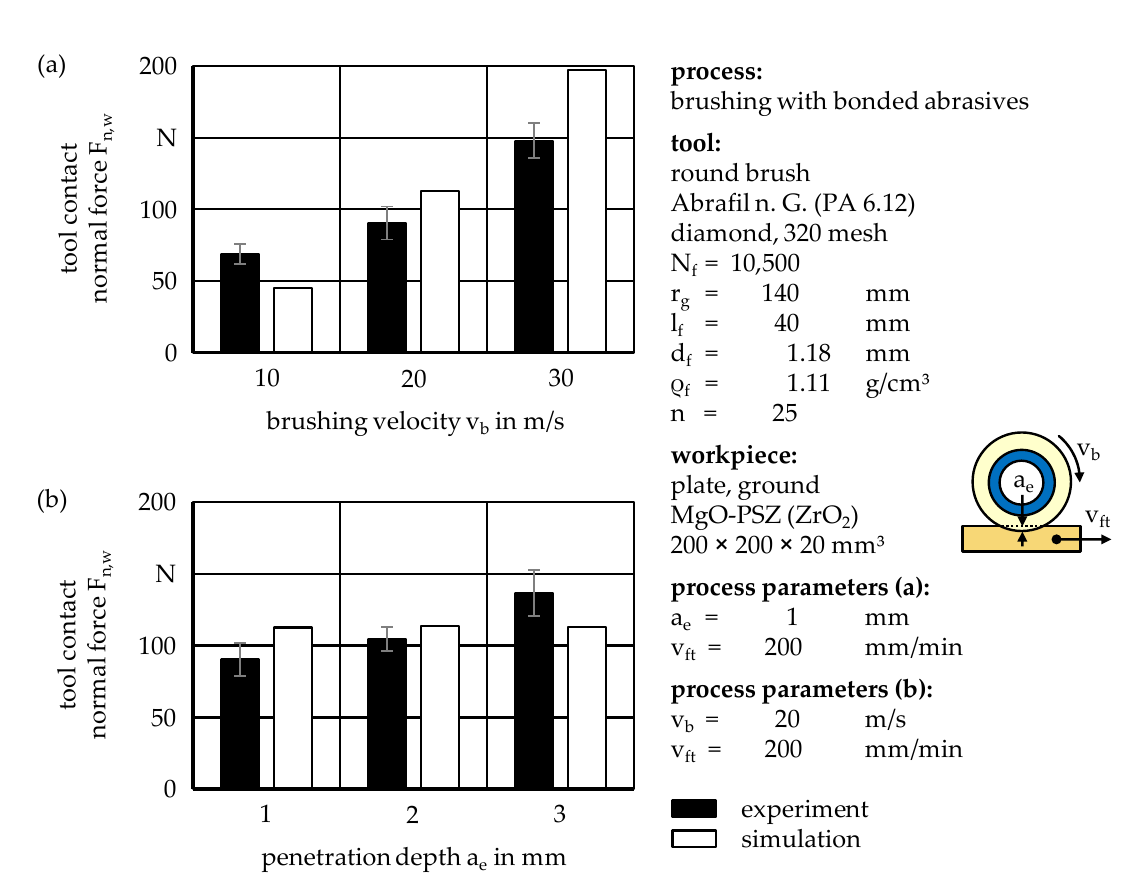
Figure 7. Tool contact normal force F n,w for different ( a ) brushing velocities v b and ( b ) penetration depths a e .